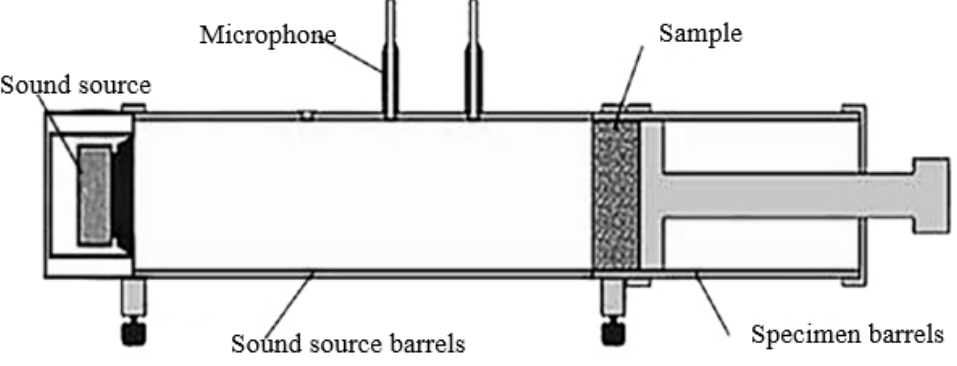
Figure 3. Schematic diagram of impedance tube test system.